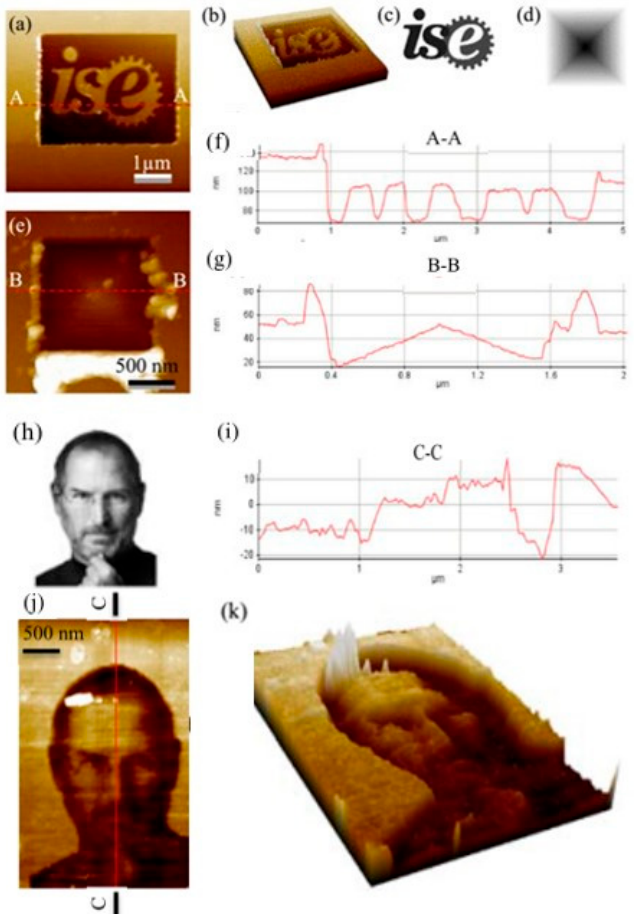
Figure 14. “ise” logo, pyramid 3D structure and the profile of Steve Jobs were fabricated by the ultrasonic vibration-assisted approach based on the TBN method: ( a ) 3D nanostructure of letters “ise”, ( b ) 3D view of “ise”, (c) bitmap images of “ise”, ( d ) bitmap images of pyramid, ( e ) fabricated pyramid nanostructure, ( f ) the image of “A-A” cross section, ( g ) the image of “B-B” cross section, ( h ) bitmap images of Jobs’ profile, ( i ) the image of “C–C” cross section, ( j ) 3D nanostructure of Job’s profile and ( k ) 3D view of Jobs’ profile [90] .